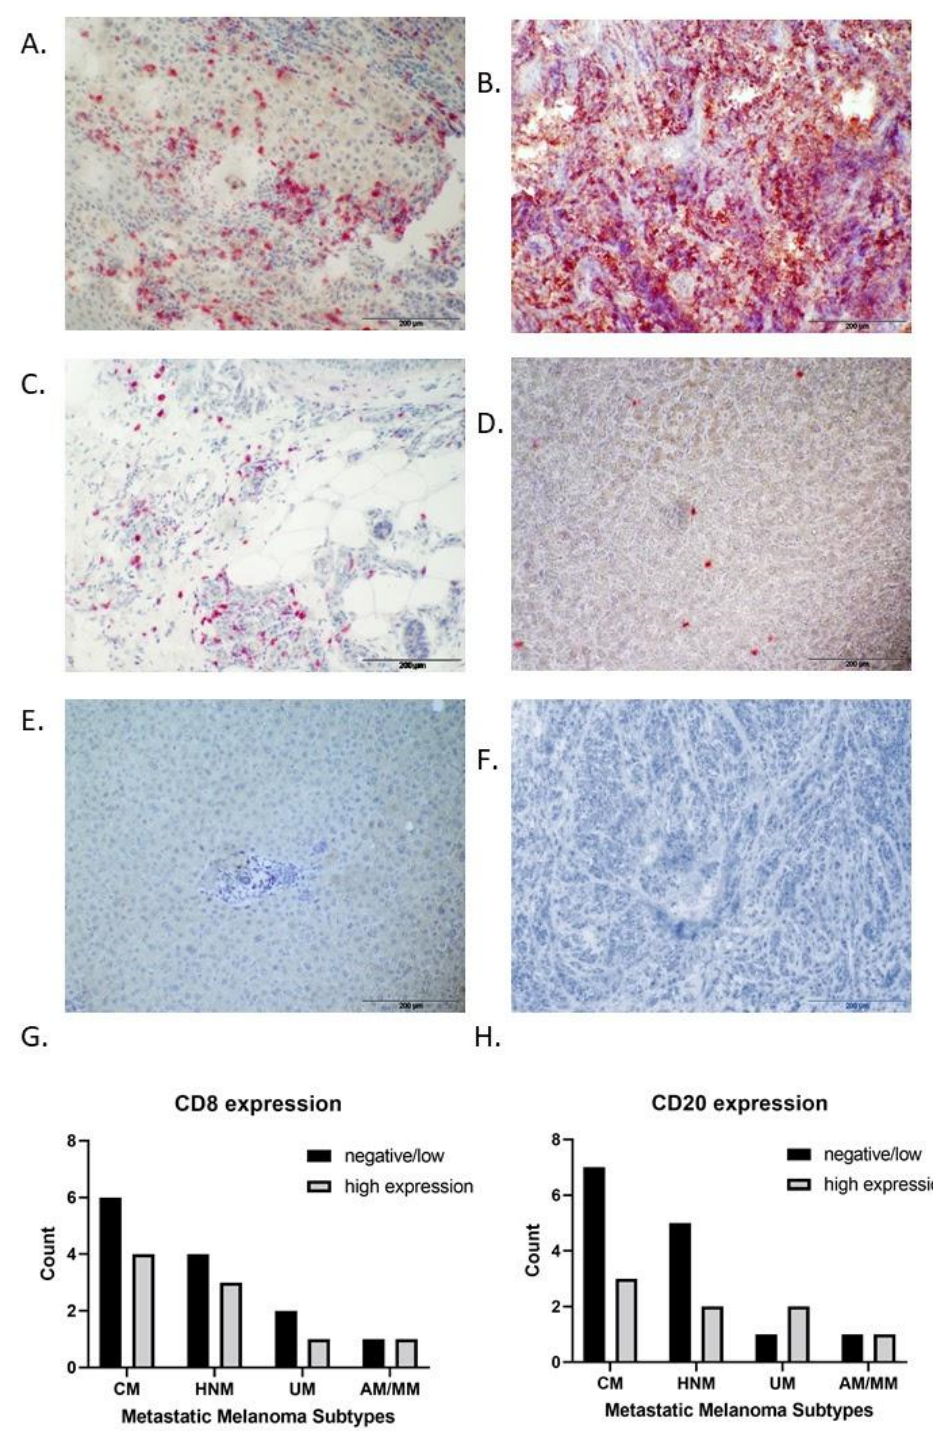
Figure 1. Immunohistochemical staining of tumour samples at × 200 magnification. Representative high expression (strong diffuse immune cell infiltration) for ( A ). CD8 in HNM, ( B ). CD20 staining in HNM. Representative low expression (peritumour and/or interstitial immune infiltration) for ( C ). CD8 in MM, ( D ). CD20 expression in CM. Representative negative expression for ( E ). CD8 and ( F ). CD20 expression in HNM. Overall expression of ( G ). CD8 and ( H ). CD20 in metastatic melanoma subtypes.